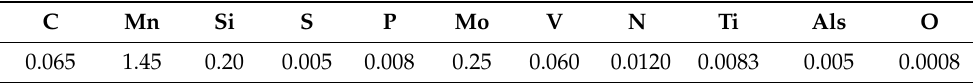
Table 1. Chemical compositions of experimental steel (wt.